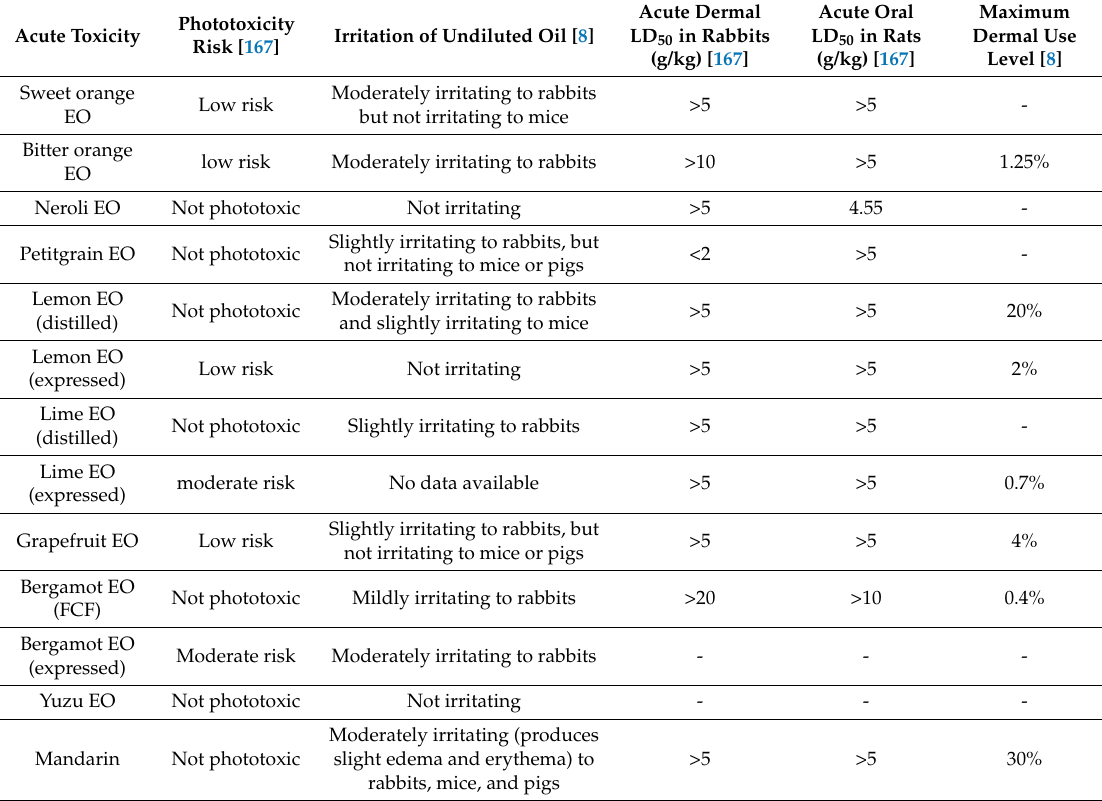
Table 4. Phototoxicity risk, irritation of the undiluted oil, acute dermal LD 50 in rabbits, acute oral LD 50 in rats, and maximum dermal use level for different essential oils from Citrus